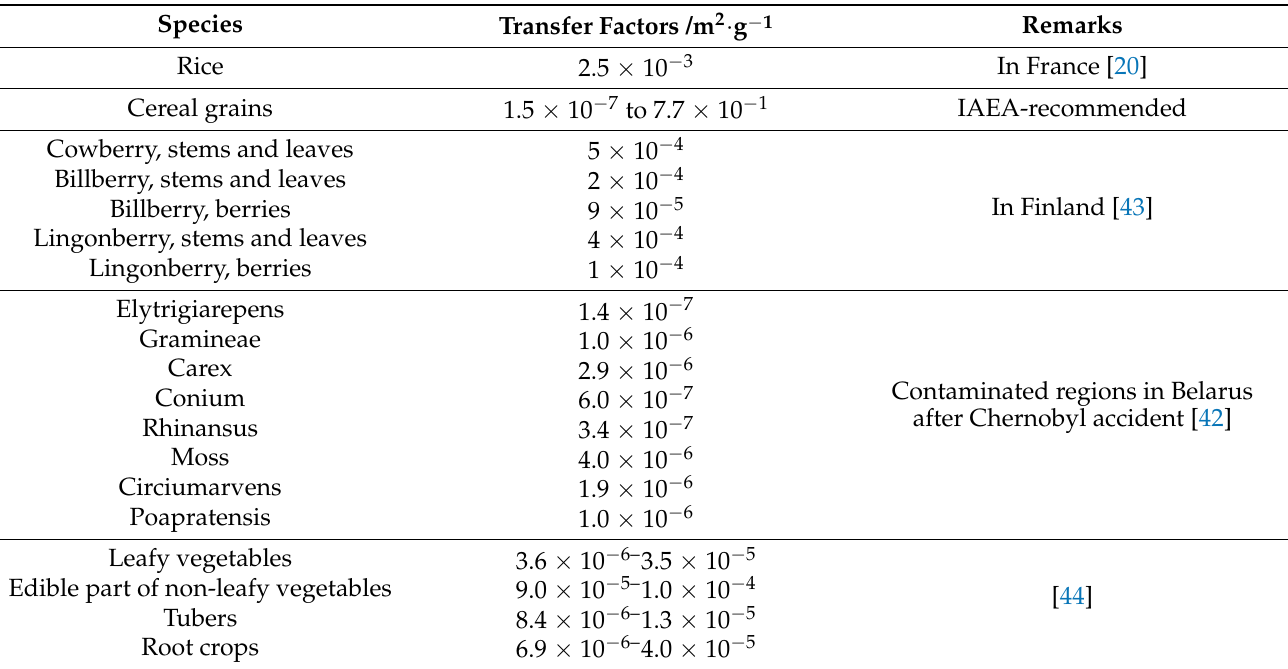
Table 3. Transfer factors for 241 Am from soil to